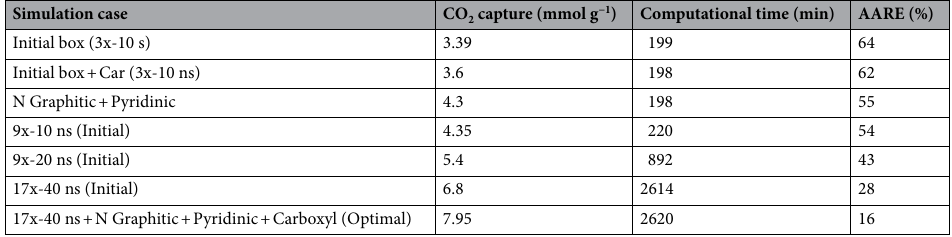
Table 4. Comparison of various structure properties in simulation